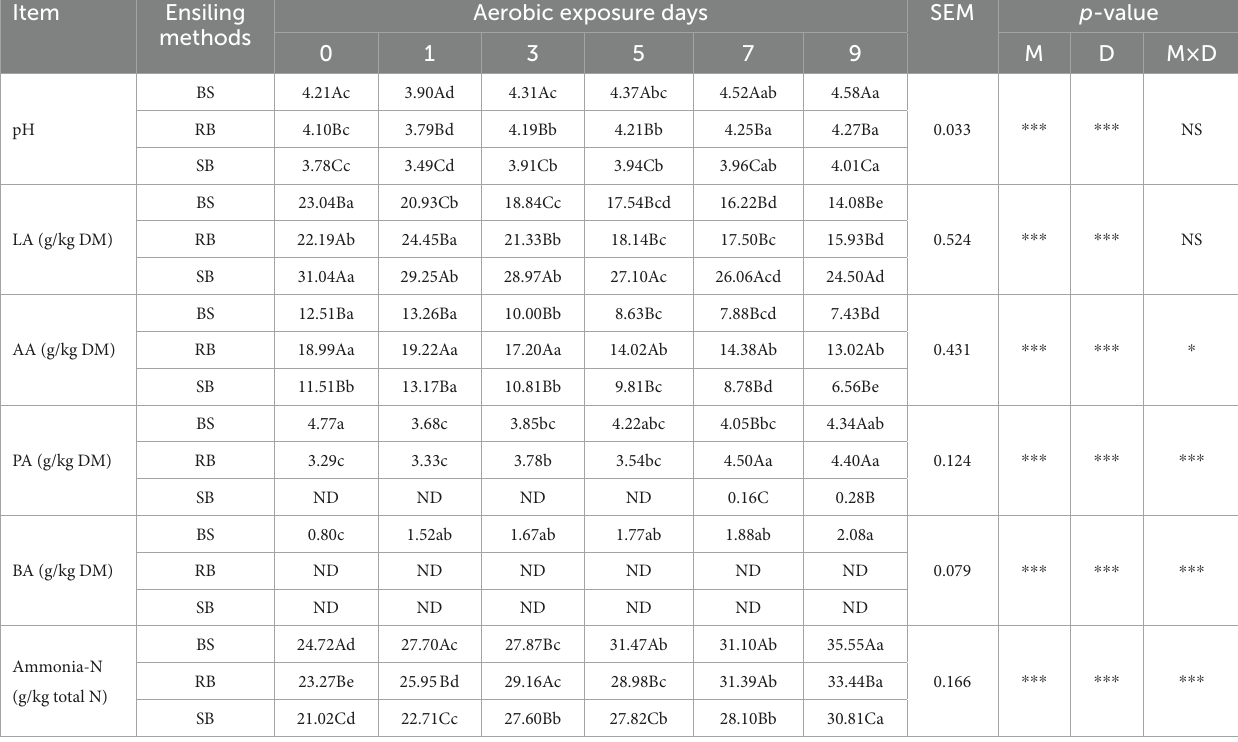
TABLE 2 Effect of different ensiling methods on fermentation quality of WPCS during aerobic